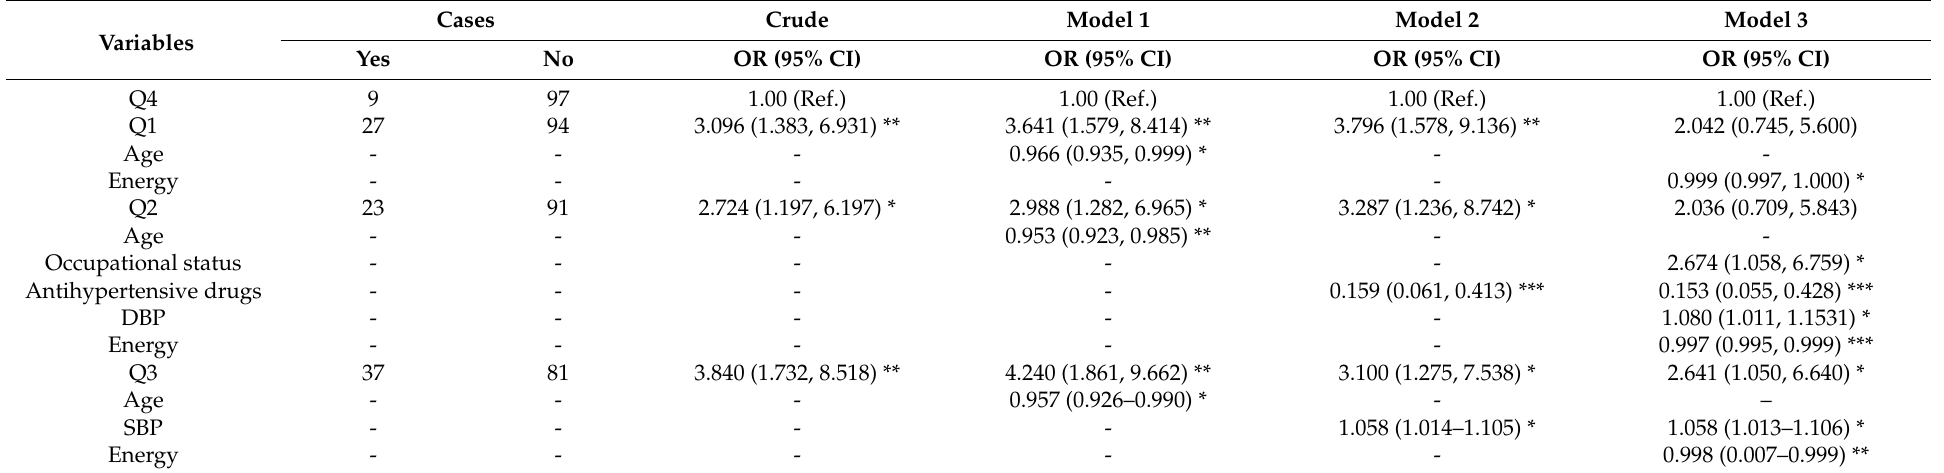
Table 4. Odds ratios and 95% confidence intervals for depression according to dietary fiber